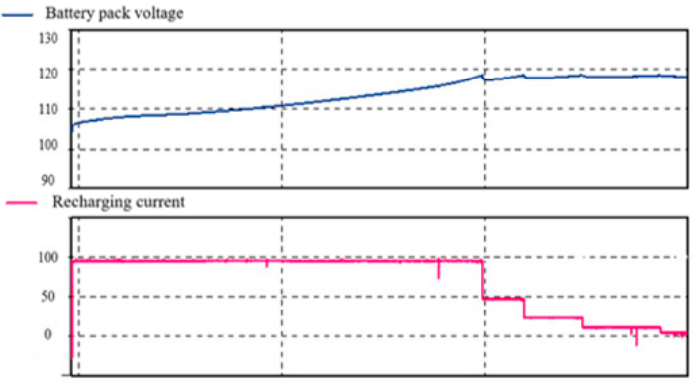
Figure 20. Pack charging experiment results.